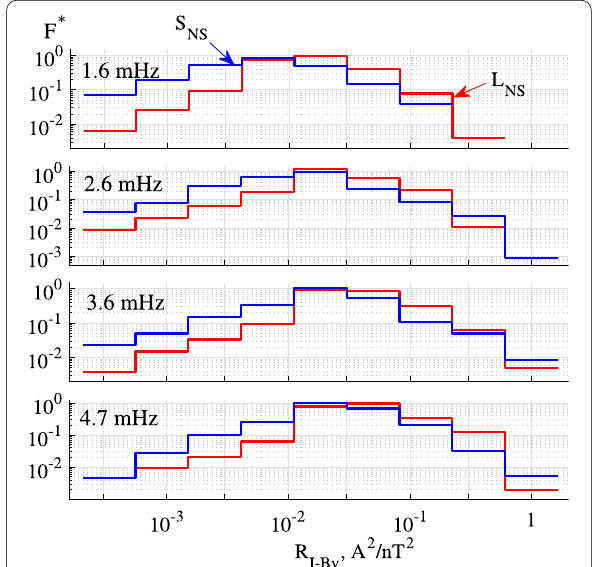
Fig. 9 R I − By normalized PDF for the N–S large ( L NS ) small-scale ( S NS ) pulsations